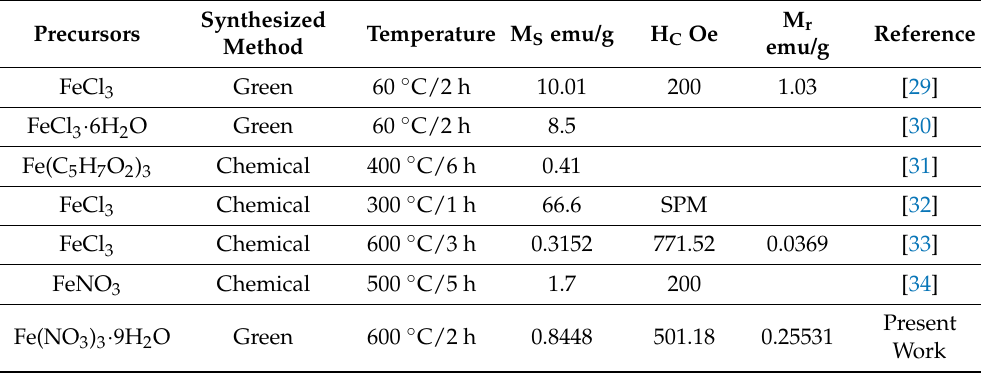
Figure 3. VSM spectrum of FNH nanoparticles. Table 1. Magnetic parameters of FNH